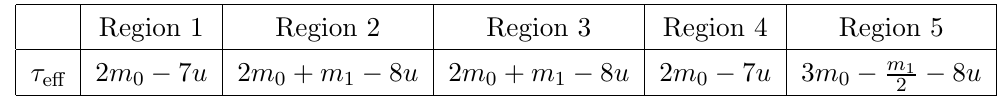
Figure 15. The 5-brane web di- agram given by taking the limit m 0 for the 5-brane web of ! 1 the E 1 in (cid:12)gure 9. A (0 ; 1) 7- brane is attached to the end of e the two NS5-branes.